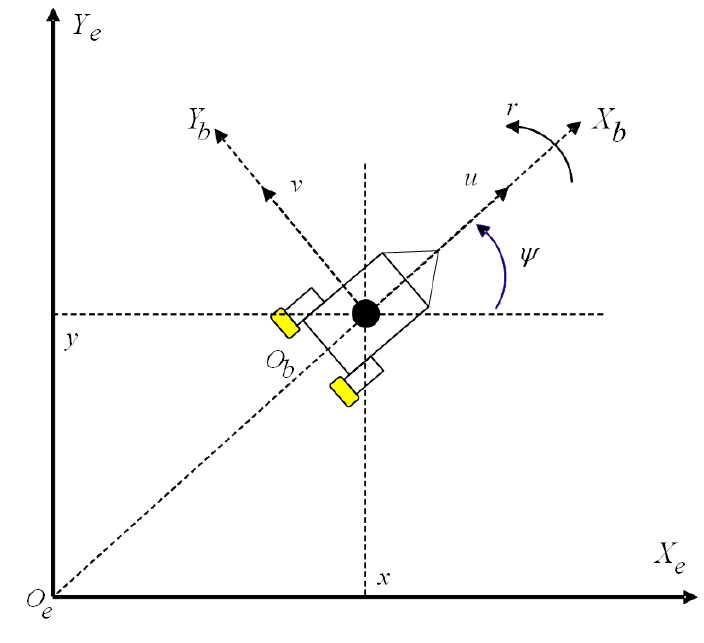
Figure 2. The dynamics and kinematics of the